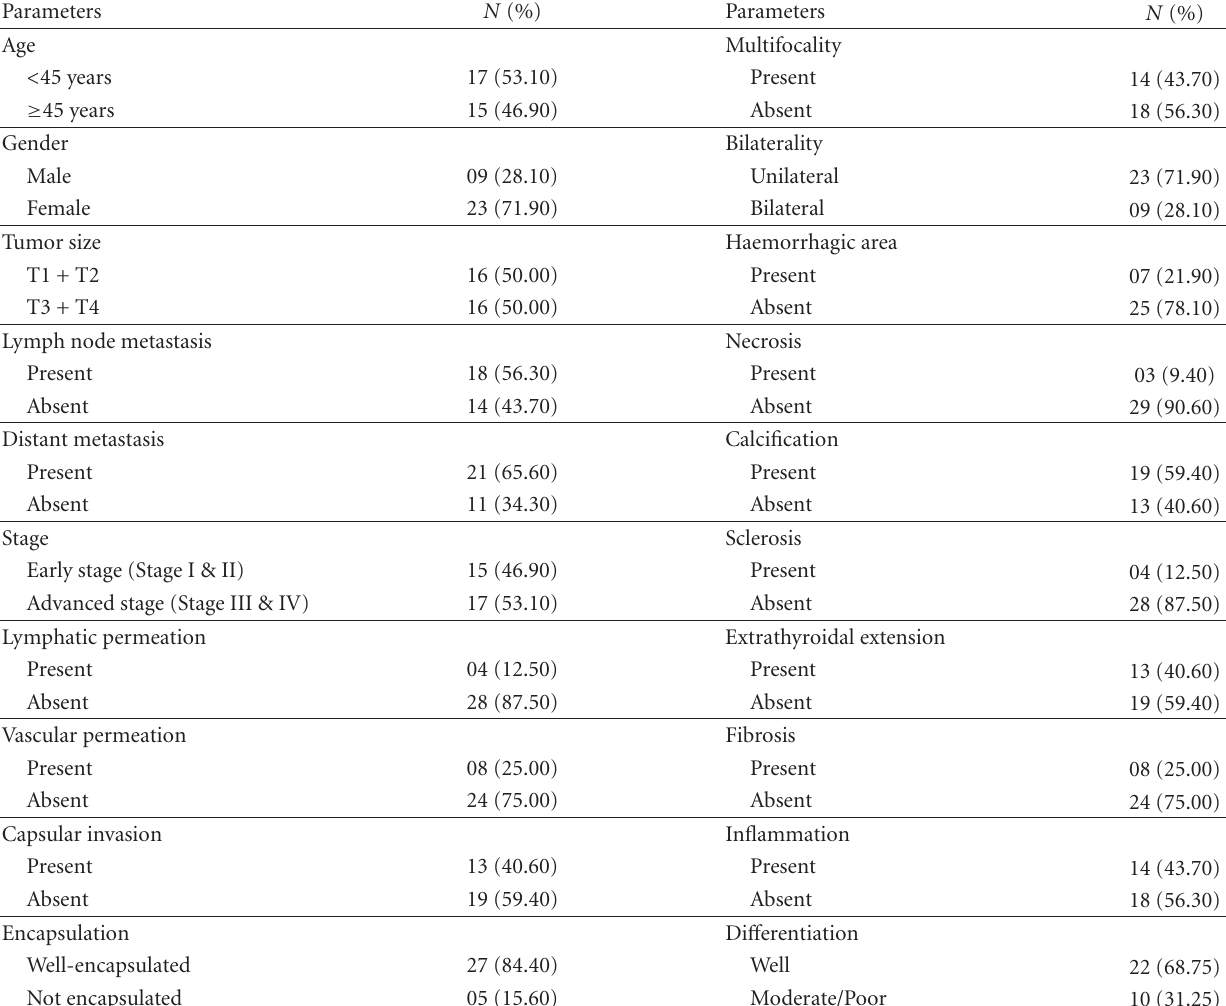
Table 2: Clinicopathological parameters of thyroid cancer patients.